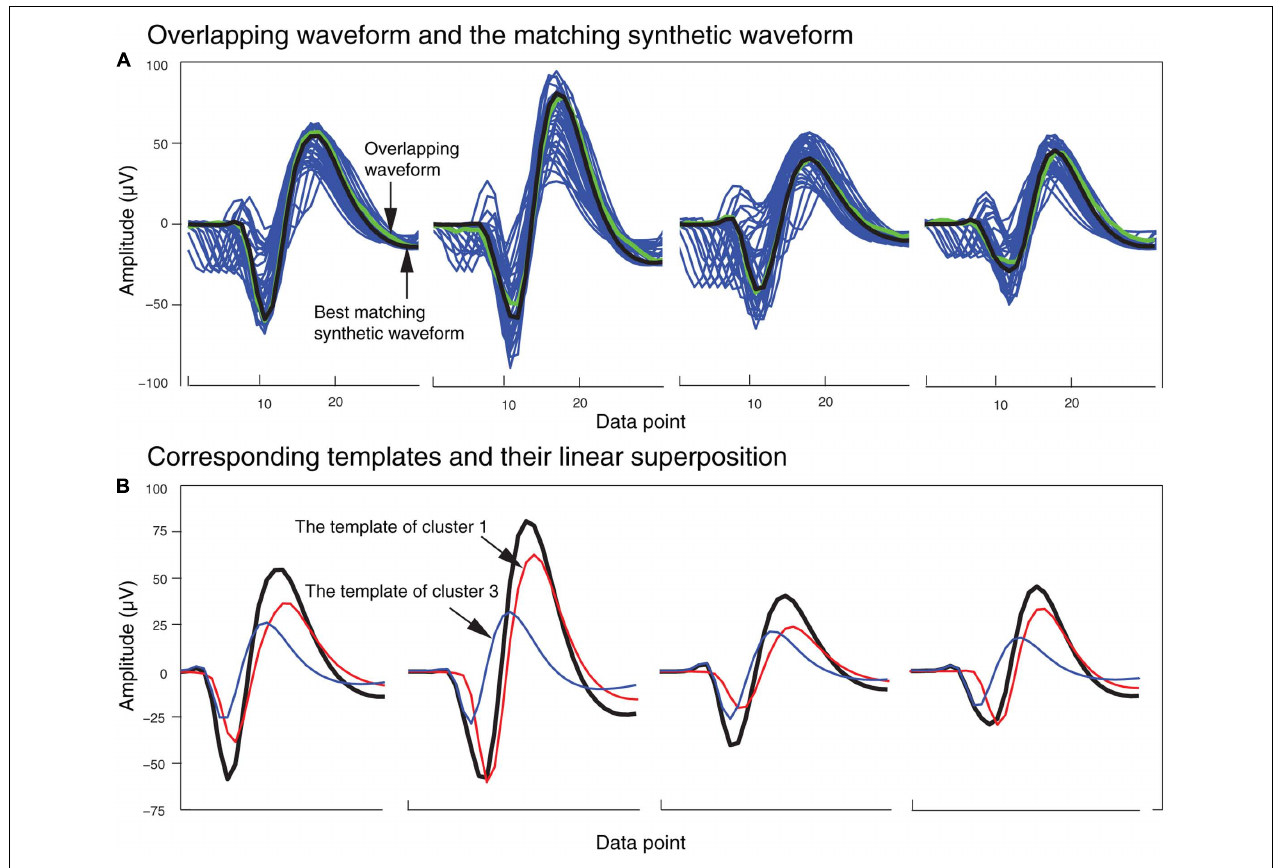
FIGURE 5 | Matching of synthetic and overlapping waveforms for the tetrode data recording shown in Figures 2 , 4 . (A) The synthetic waveforms (blue) clustered with one overlapping waveform (green) are shown with the best-matched synthetic waveform highlighted in black. (B) The template waveforms (blue and red) that generated the synthetic waveform (black) shown in (A) . The cluster numbers refer to the cluster numbers in Figure 2B